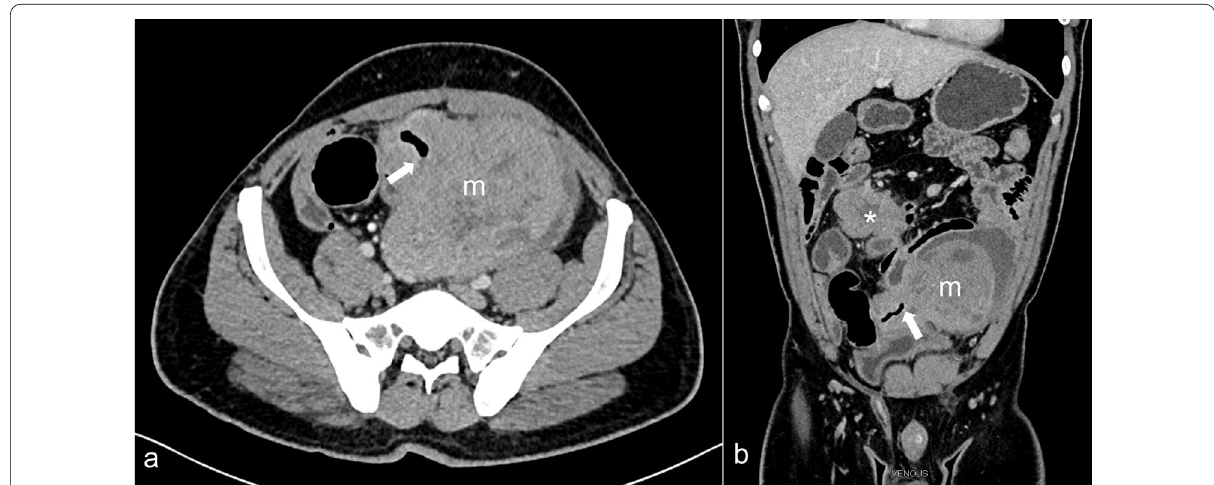
Fig. 1 Contrast-enhanced computed tomography (CECT) venous phase axial a and coronal b images showing a heterogeneously enhancing mass (m) in left lower abdomen with evidence of fistulous communication (white arrow) with the adjacent ileal loop. The mass is surrounded by a rim of fluid. Another similar density lesion (asterisk) is noted on right side of abdomen